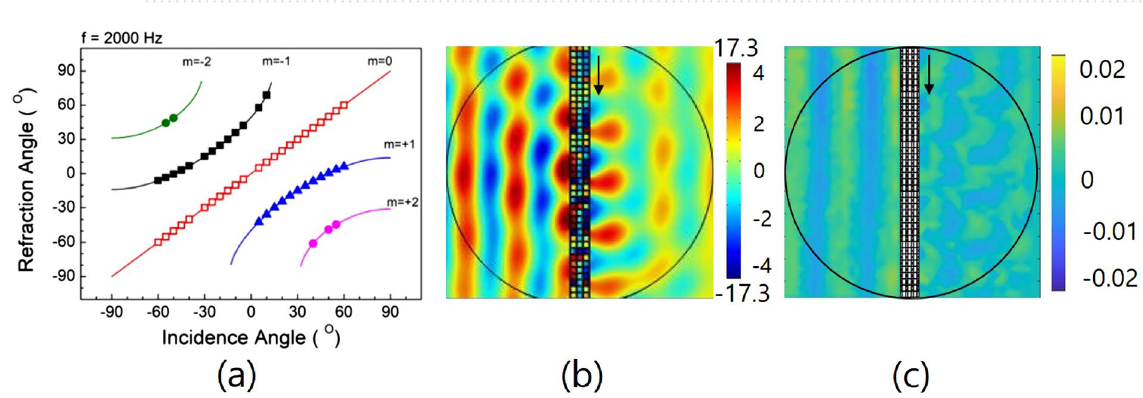
Figure 4. ( a ) shows the relation between the incident angle and the refractive angle of sound waves by the designed metasurface. The solid lines and marked symbols are the theoretically calculated and numerically simulated results, respectively. The reference frequency and the phase gradient of the designed metasurface are 2000 Hz and 8.93 π rad/m, respectively. ( b ) shows the simulation results at the characteristic frequency of 1540 Hz at normal incidence, and ( c ) shows the experimental